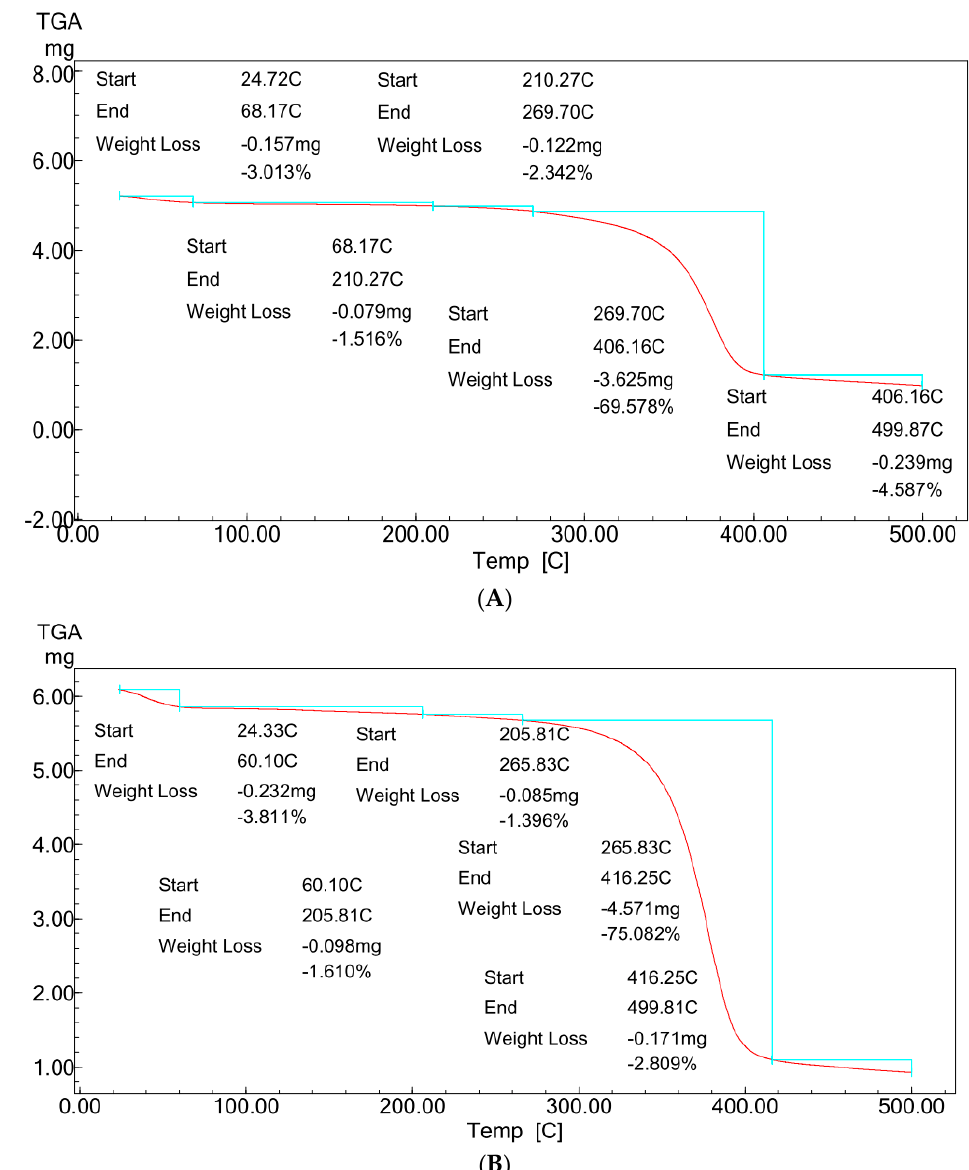
Figure 5. TGA profiles of ZnO polymeric nanofiber ( A ) before silver immobilization and ( B ) after silver immobilization.